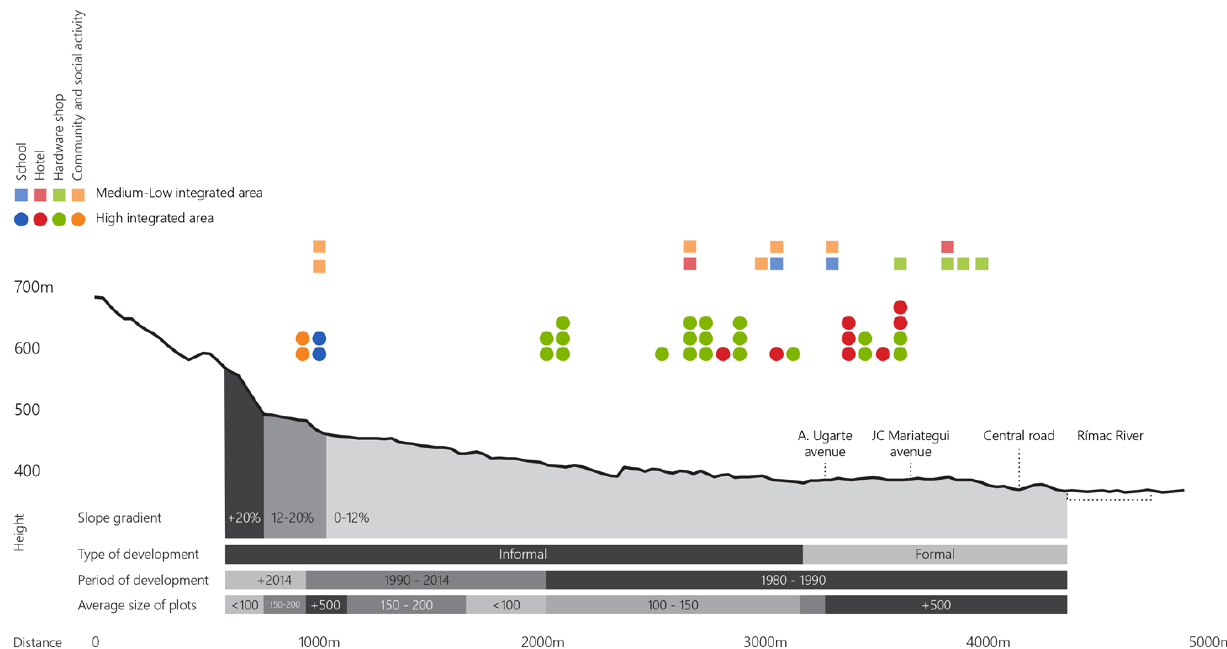
Figure 7. Spatial characteristics and location of activities in Valle Amauta on the cross-section. Source: Authors, based data from INEI (2019), Ministry of Education of Peru (2019), Ministry of Environment of Peru (2019), Municipality of Ate (2016) and Municipality of Lima